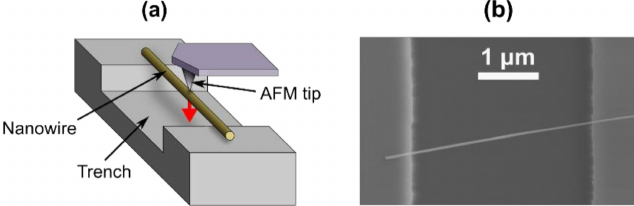
Figure 2. ( a ) Schematic of the AFM 3-point bending test; ( b ) SEM image of a typical CuO nanowire on a trench (top